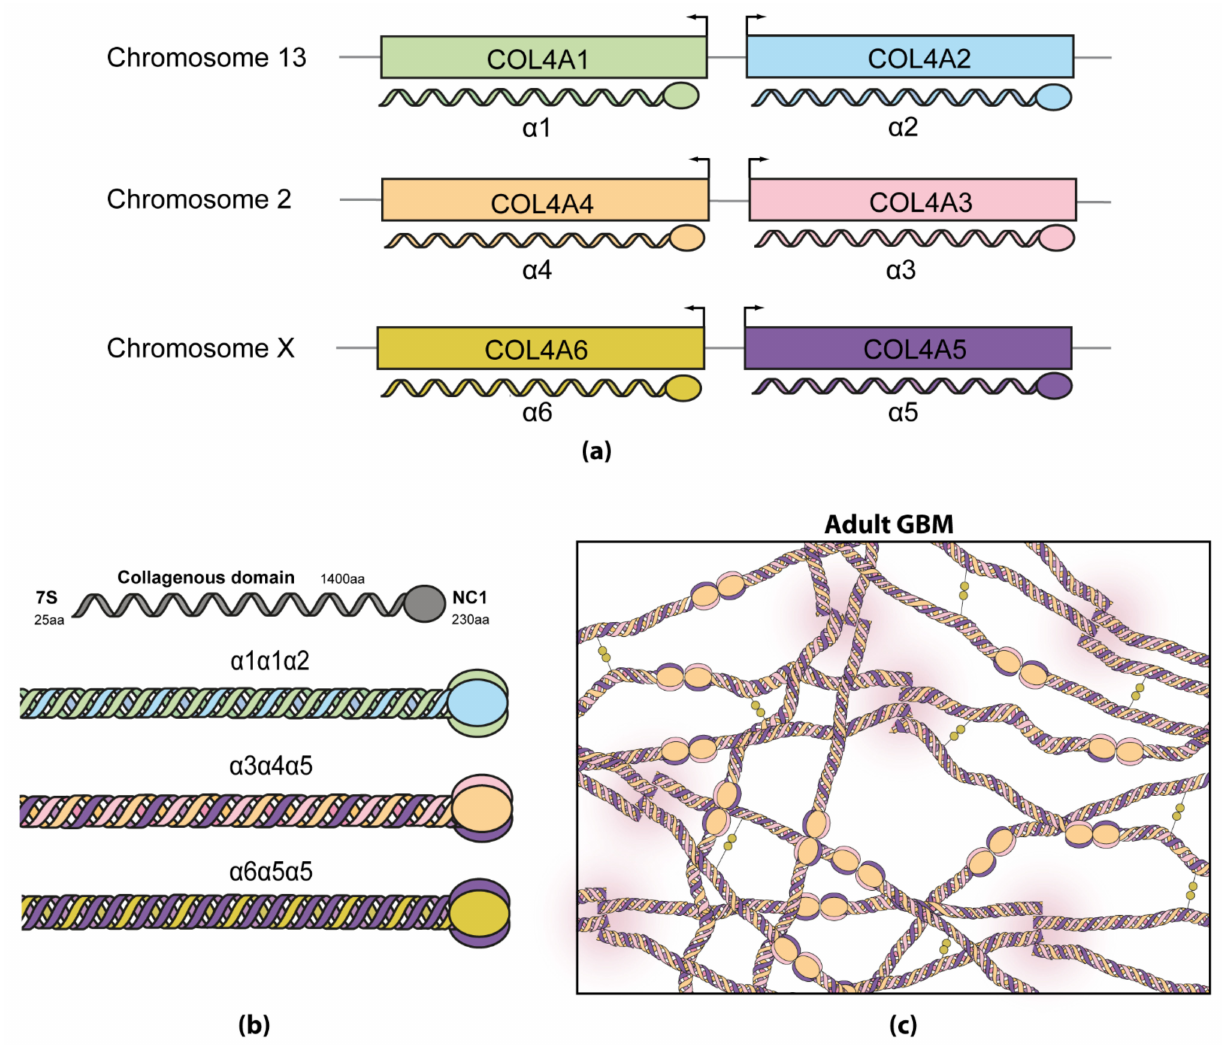
Figure 2. ( a ) Type IV collagen genes (COL4A1–COL4A6) are located in three different chromosomes pairwise, that encode the corresponding α -chains ( α 1– α 6). ( b ) α -chains can be combined among each other in three different ways, forming triple helices (trimers). ( c ) In adults, collagen α 3 α 4 α 5 trimers associate by C and N termini, creating a crosslinked network reinforced by disulfide bonds (gold